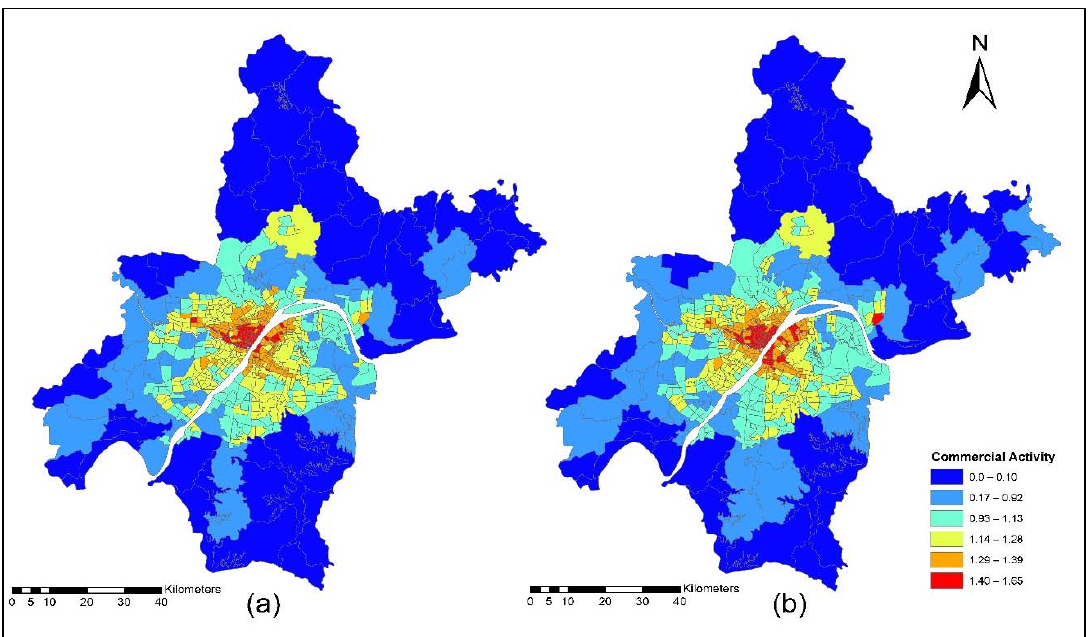
Figure 19. ( a , b ) Accessibility of commercial activities: ( a ) during evening peak for year 2012; ( b ) during evening peak for year 2015.